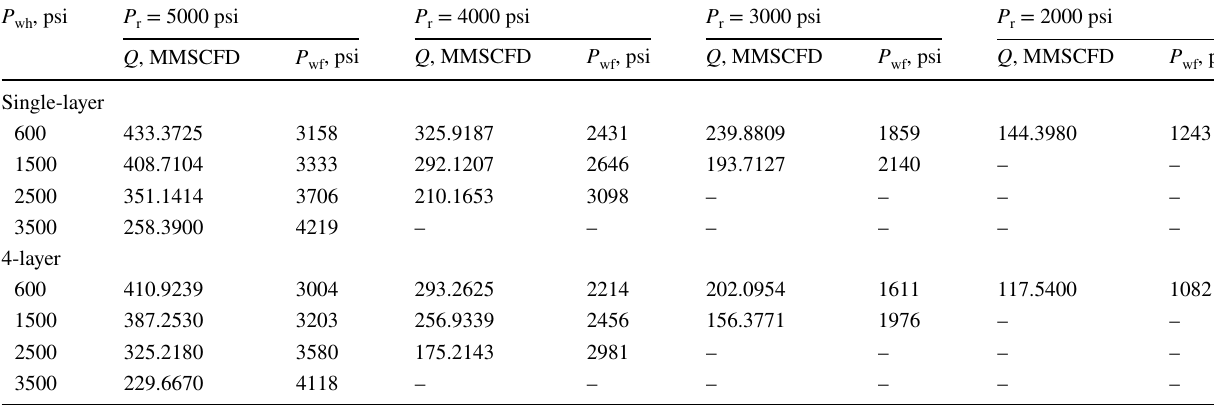
Table 13 Operating points through nodal analysis for single-layer and 4-layer reservoir model P wh ,